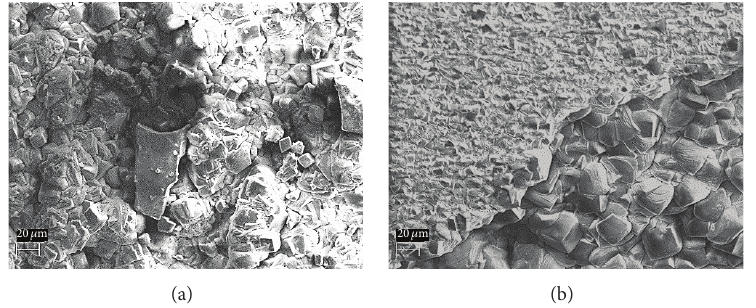
Figure 2: SEM image of scale after exposure in autoclave: (a) B-N specimen, (b) B-WQ specimen.